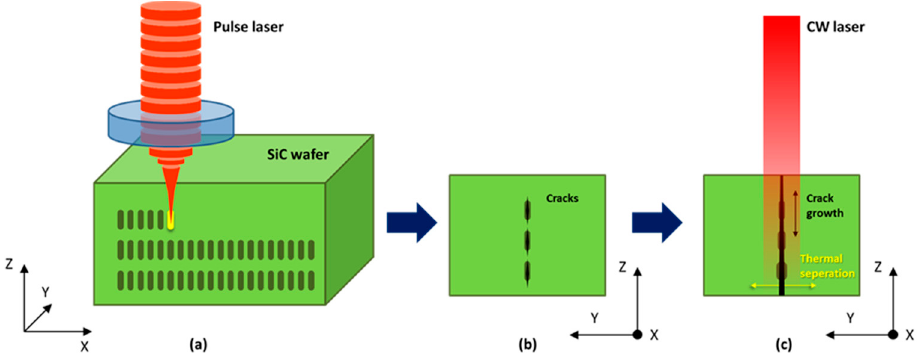
Figure 2. The schematic of the FEM model. ( a ) The stealth dicing process with the pulse laser, ( b ) the internal void produced from ( a , c ). The crack growth process caused by the CW laser.